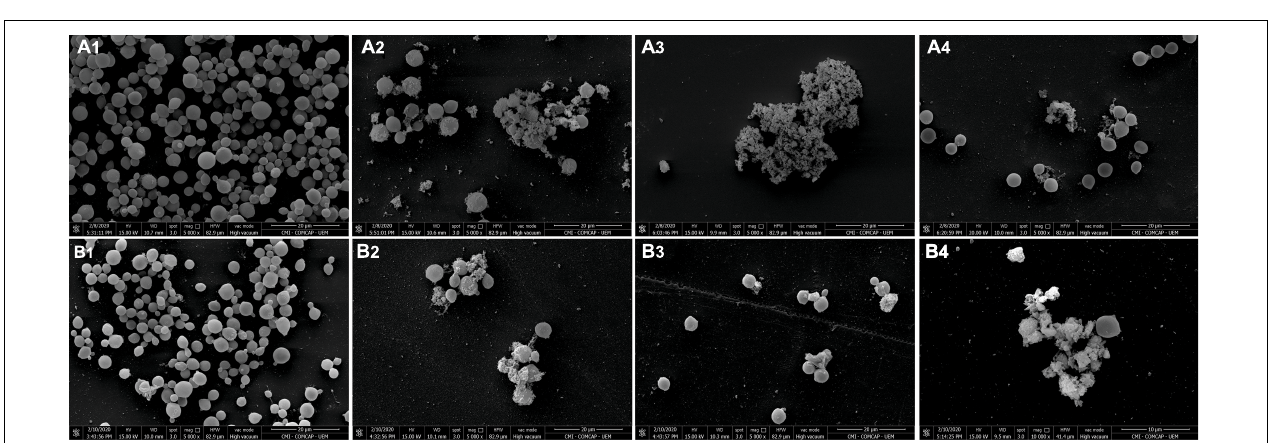
FIGURE 4 | Effect of ethyl acetate fraction (EAF) of Poincianella pluviosa on 48-h biofilm of Cryptococcus neoformans . Metabolic activity of sessile cells was assessed by the dimethylthiazol diphenyltetrazolium bromide (MTT) reduction method after 48-h incubation at 37 ◦ C with different concentrations of EAF. Values are mean ± standard deviation of two experiments in quintuplicate and were analyzed by one-way ANOVA. Asterisks indicate a significant reduction ( p < 0.05) in the metabolic activity of treated sessile cells compared to untreated cells.